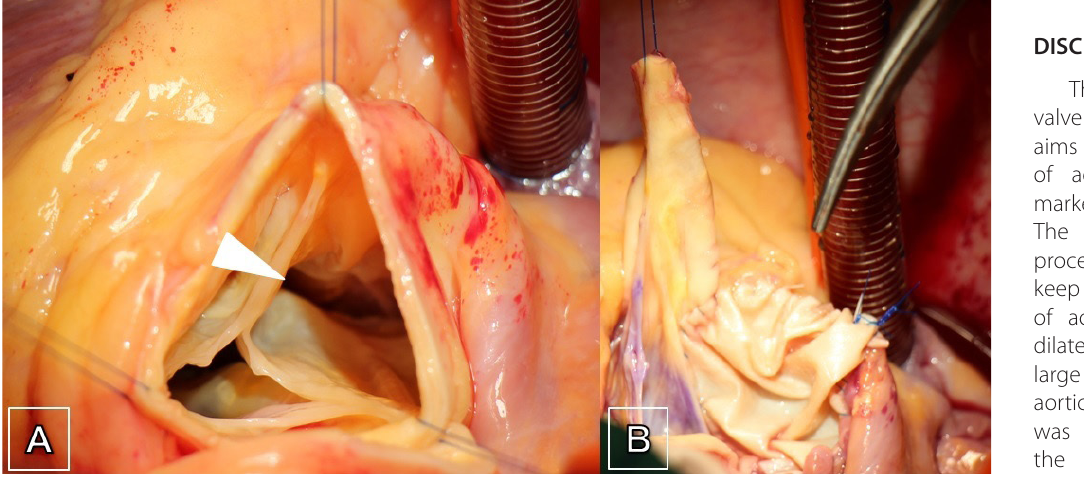
Fig. 2 - Intraoperative findings of the perforated sinus of Valsalva aneurysm with an aorto-right atrial shunt (arrow) and the asymmetric tricuspid aortic valve configuration (A) and the closure of the right atrial shunt with bovine pericardial patch (B) before aortic valve reimplantation was